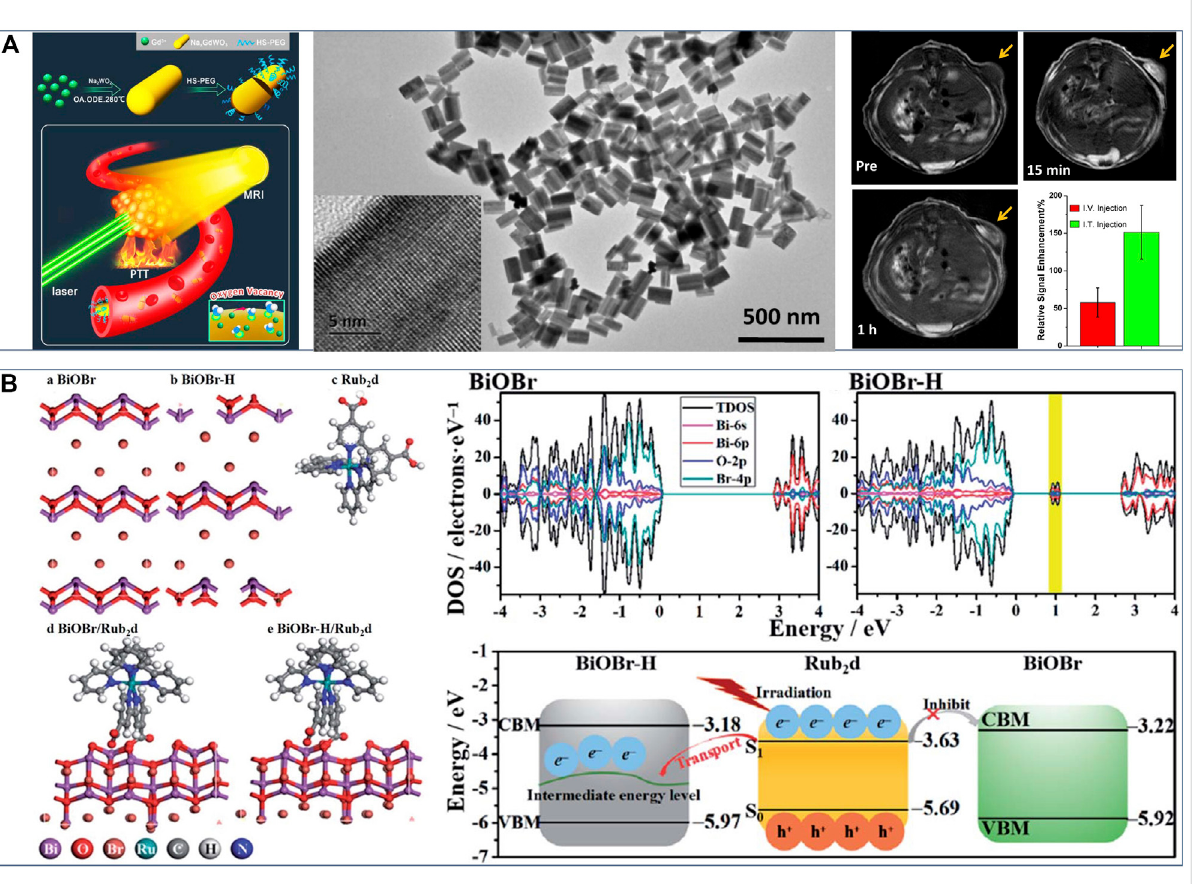
FIGURE 3 (A) Schematic diagram of Na x GdWO 3 nanorods for MRI-guided photothermal, TEM images of Na x GdWO 3 nanorods, and in vivo T 1 -weighted MR images of 4T1-tumor-bearing mice before and after (I)T. injection of Na x GdWO 3 nanorods. Reproduced with permission from Ni et al. (2017). Copyright © 2017 American Chemical Society. (B) Schematic illustration of geometric structure of various BiOBr-based samples and Rub 2 d sample, band structures of BiOBr and BiOBr – H, and the band edge positions of BiOBr, BiOBr – H and Rub 2 d. Reproduced with permission from Guan et al. (2019). Copyright © 2019 The Royal Society of